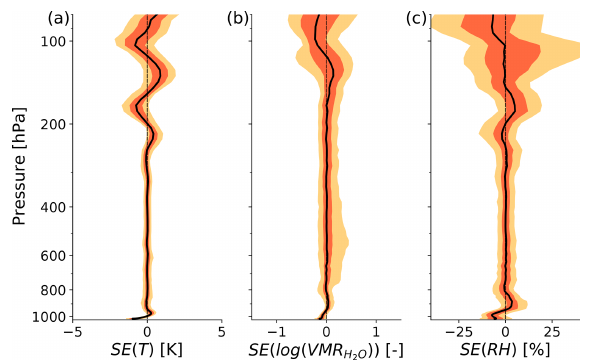
Figure 7. Smoothing error (SE) as calculated by Eq. (4) of retrieved temperature (a) , logarithmic VMR H 1288 tropical ocean atmospheres. Lines and shadings are defined as in Fig.